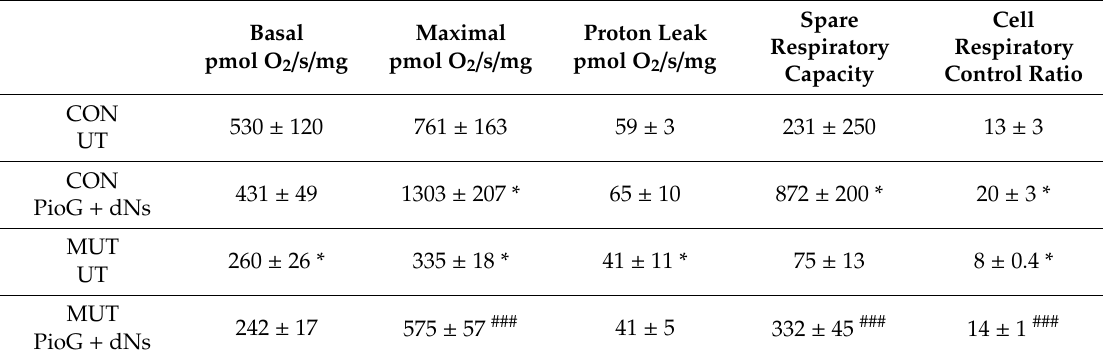
Table 1. Respiration rates in untreated and PioG + dNs-treated control and mutant cybrids.